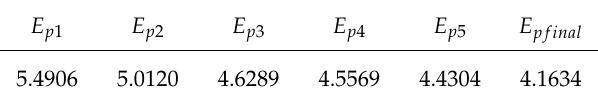
Table 2. The image entropies of subimages and fusion image of the conical